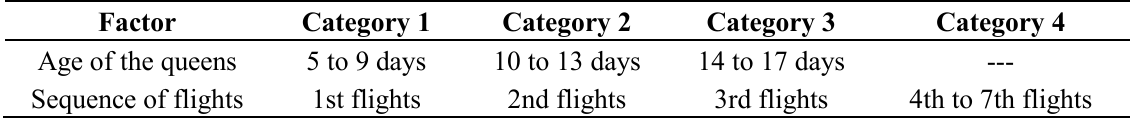
Table 2. Grouping of the data concerning the queen’s age and the sequence of flights. All queens were kept in a dark room at 15 °C until they were brought to the mating